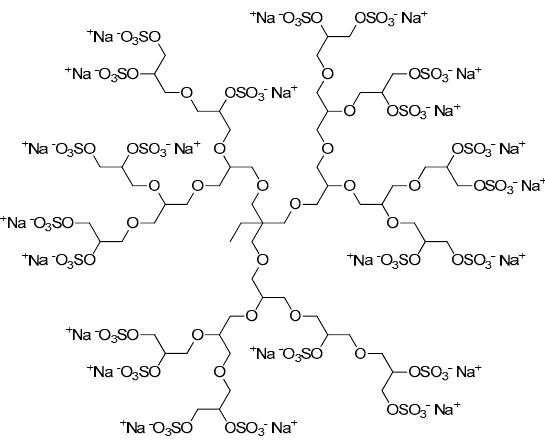
Figure 2. Representative and idealized structure of dendritic polyglycerol sulfate (dPGS).